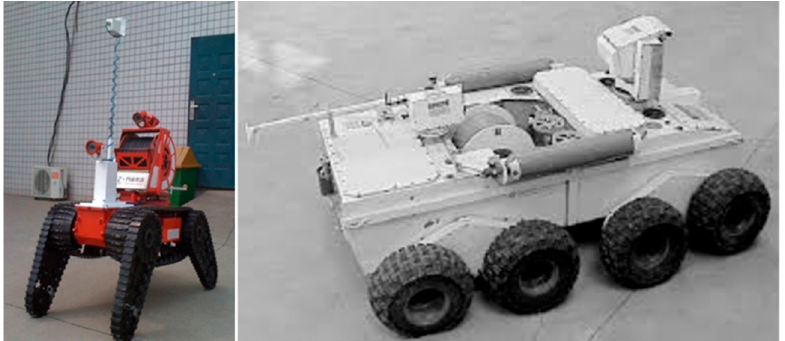
Figure 1. Minibot-II robotic platform (left), Robot Numbat (right).